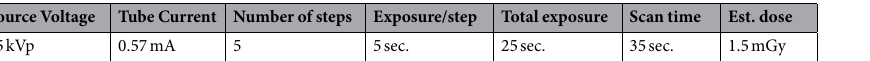
Table 1. Small-animal CT scanner acquisition parameters used for the in-vivo X-ray dark-field radiography lung cancer